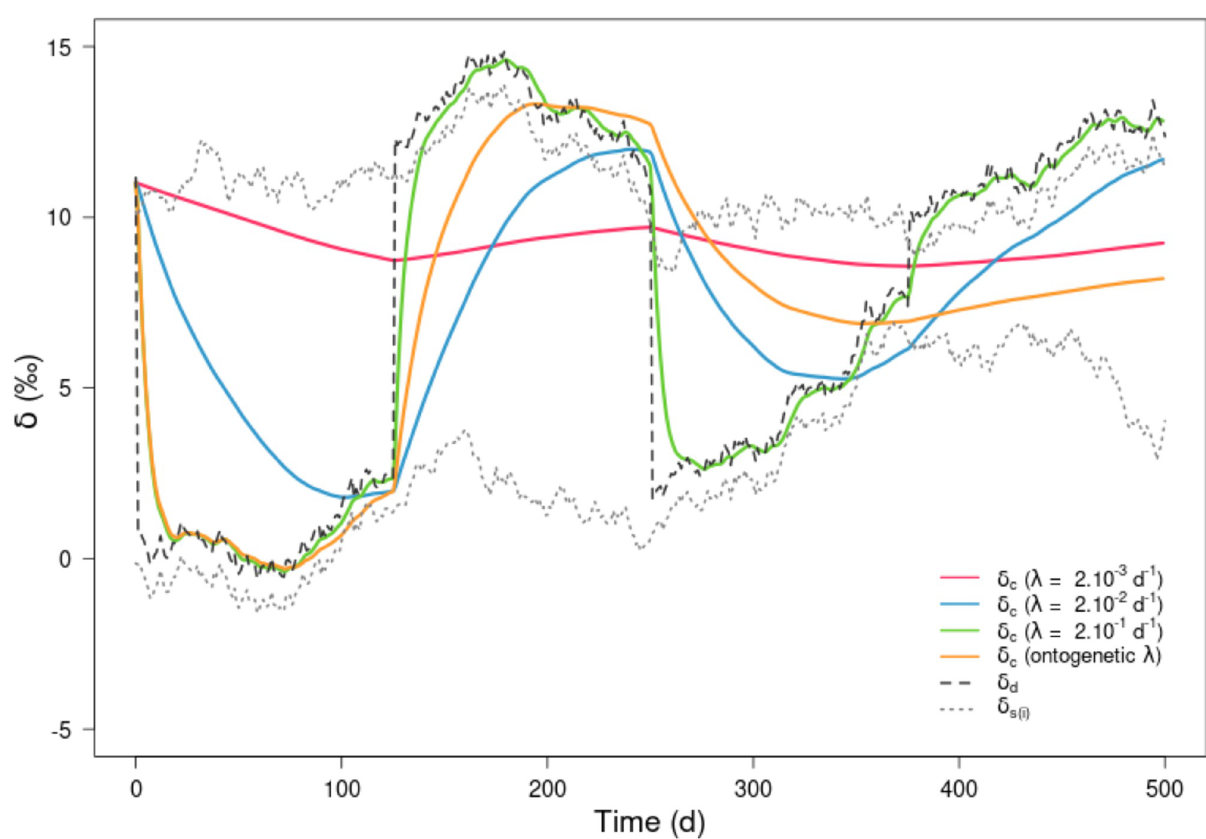
Fig 3. Simulated isotopic values of consumer ( δ ( t )) over T = 500 d, for contrasted isotopic turnover rates (constant λ values in red, blue and c green lines and ontogenetic λ in orange line) and experiencing a variable diet ( δ ( t ) in dashed dark line) resulting from four diet-switches d ( ω = 0.008 d -1 ) between two food sources ({ δ s ( a ) ; δ s ( b ) } in thin dashed grey lines) as simulated with Brownian trajectories. The ratios ω / λ were respectively 4, 0.4 and 0.04 for constant λ values and ranging from 6 to 0.04 for ontogenetic λ . Note that for each of the food source, the trophic discrimination factors ( Δ s ( i ) ) were set to 1